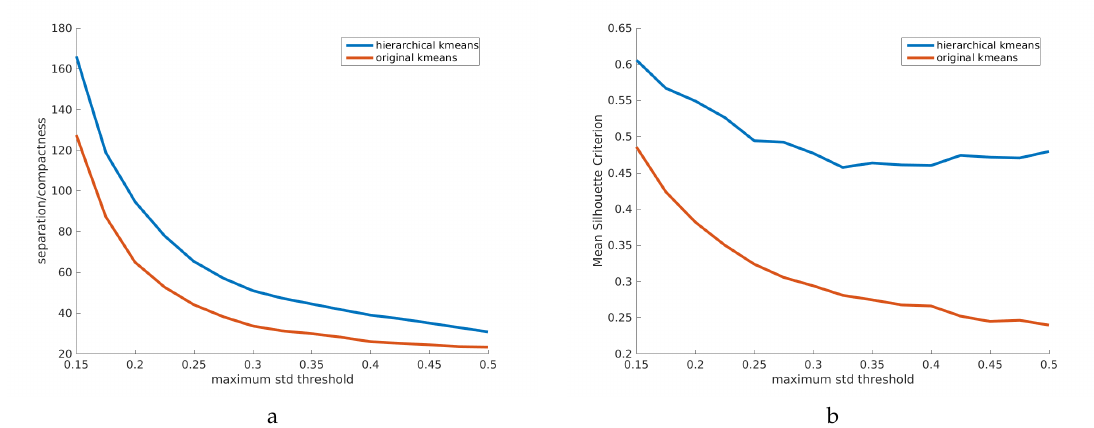
Figure 5. Clustering performance metrics of original vs. hierarchical k-means for a range of cluster variance thresholds. We have compared: ( a ) the ratio separation/compactness and ( b ) the mean Silhouette criterion, which show that hierarchical k-means provides more separated, compact and consistent clusters.